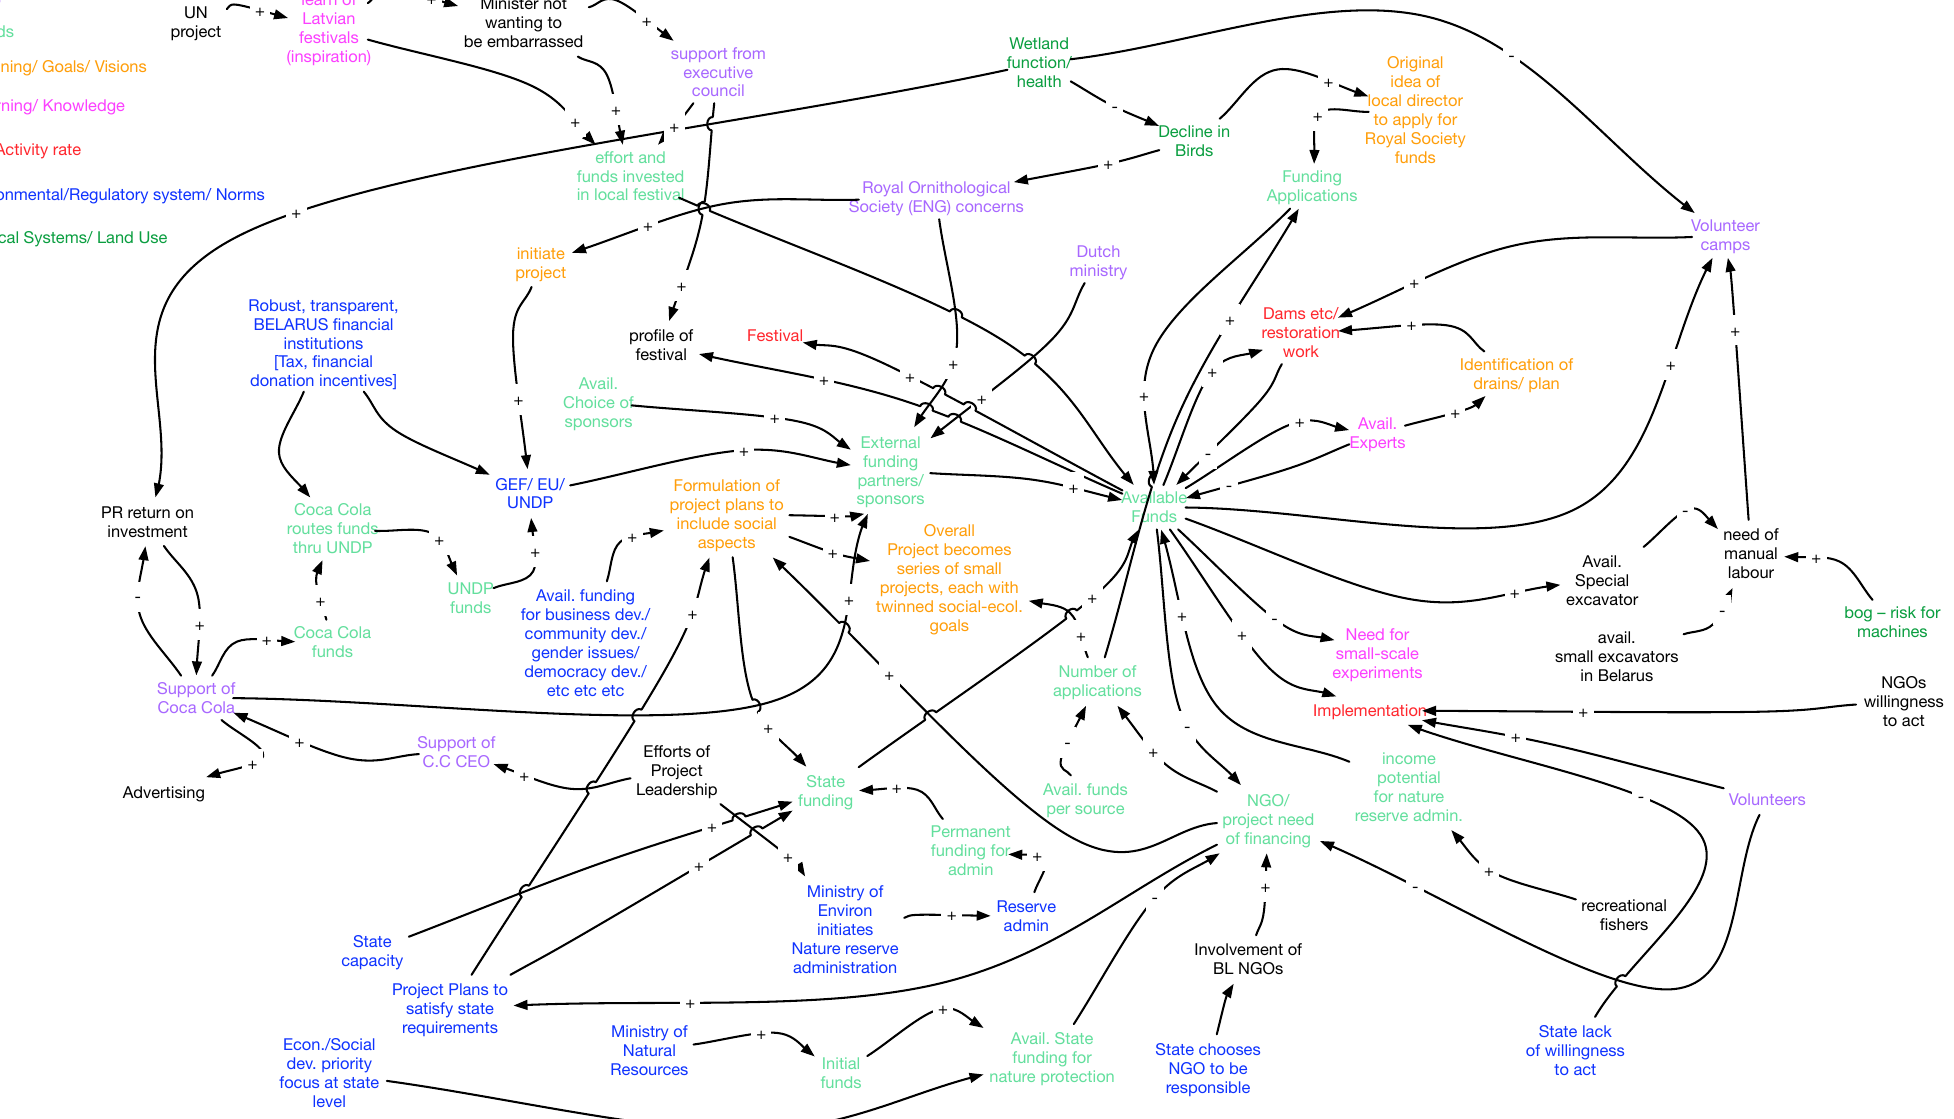
Figure A2:2. Case Bogs, Theme: Financing, funds,